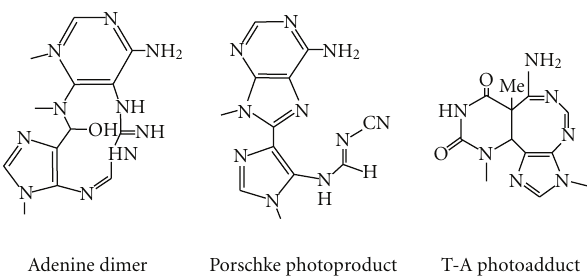
Figure 6: Structure of purinic photoproduct, that is, adenine dimer, porschke photoproduct and thymine-adenine